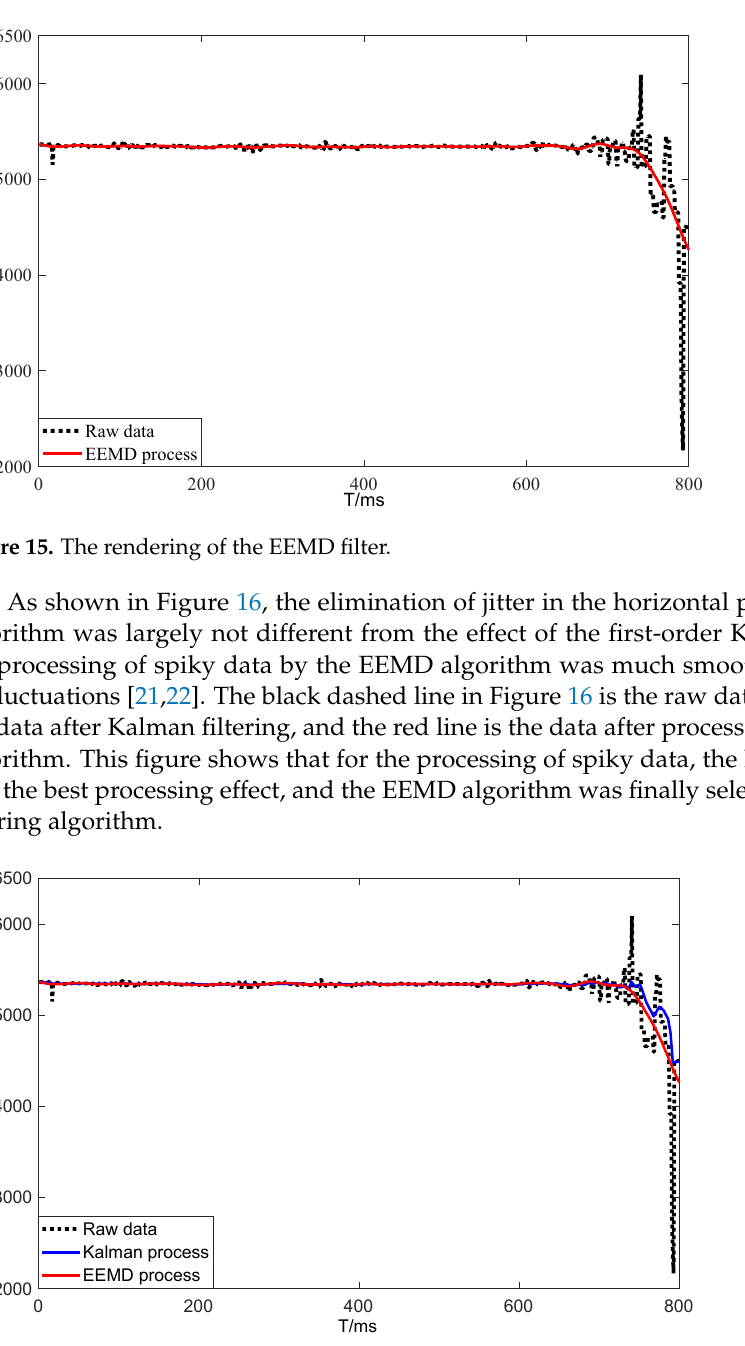
Figure 17. The rendering of the Kalman-EEMD fi lter. A polynomial fi t was used to fi t the raw data, and the fi tt ing results are shown in Figure 18, with the red line representing the raw data and the black line the fi tt ed data. The third-order fi t and fi fth-order fi t in the fi gure are poor, and the fi t graph appears to overshoot after exceeding the ninth-order. Through experimentation, the ninth-order fi t was found to be the best. The results were compared with the Kalman-EEMD fi ltering e ff ect, and the results are shown in Figure 19.